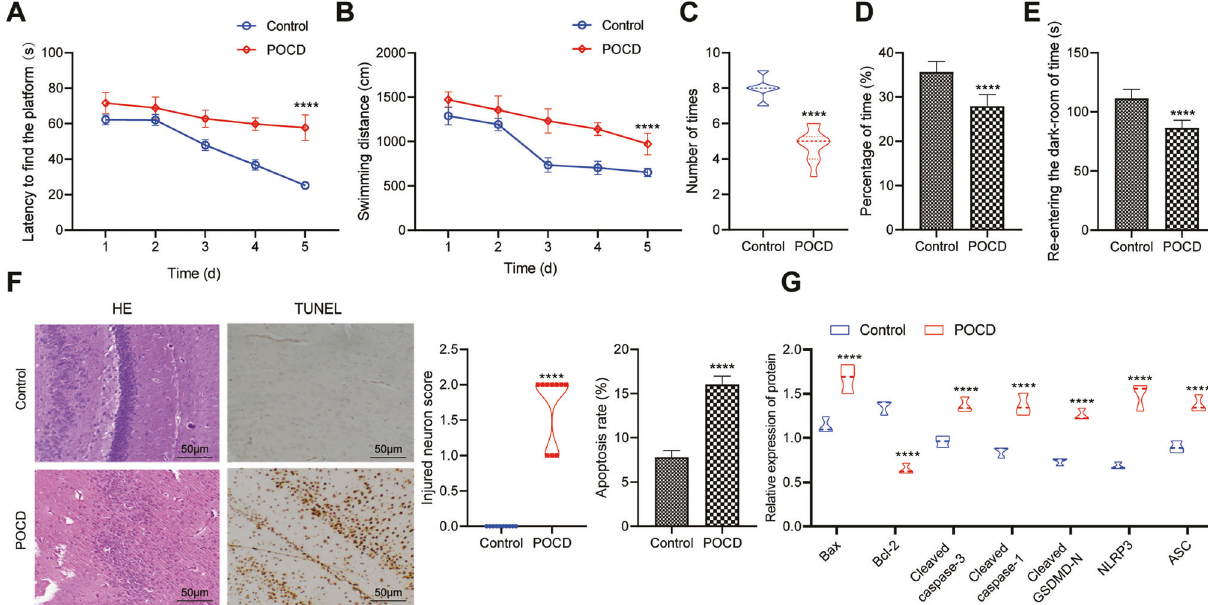
Fig. 1 A POCD rat model is successfully induced. A Time for rats to fi nd hidden platform in water maze after POCD modeling. B Swimming distance of rats before fi nding the platform hidden in the water maze after POCD modeling. C The times of rats crossing hidden platform in water maze after POCD modeling. D The residence time ratio of rats on the hidden platform of water maze after POCD modeling. E The time for rats to re-enter the darkroom in the step-through test after POCD modeling. F H&E staining (left) and TUNEL staining (right) for detecting pathological and apoptosis in the hippocampal tissues of rats after POCD modeling. G Western blot analysis to detect the protein expression of neuron apoptosis- and pyroptosis-related factors in hippocampal tissues after POCD modeling. There were ten rats in each group. * p < 0.05, ** p < 0.01, and *** p < 0.001 vs. the rats without Sevo